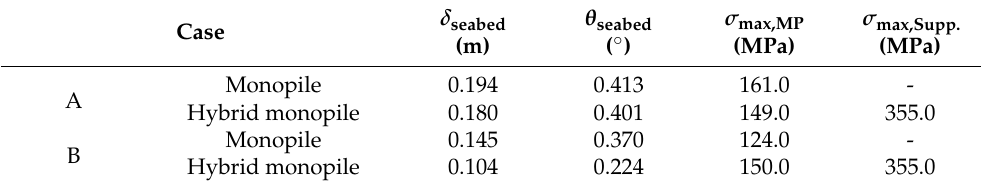
Table 7. Result comparison with cases A and